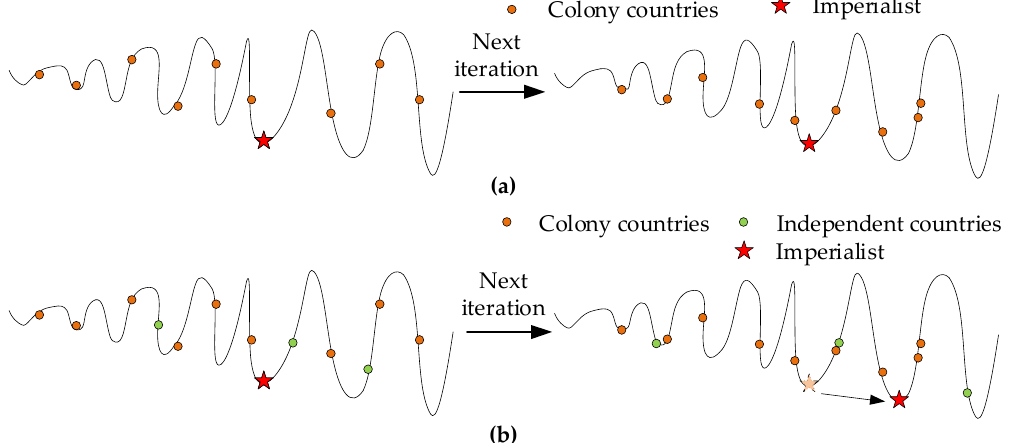
Figure 3. ( a ) Moving steps of the imperialist competitive algorithm (ICA); ( b ) moving steps of the particle swarm optimization (PSO) ICA (PSOICA).